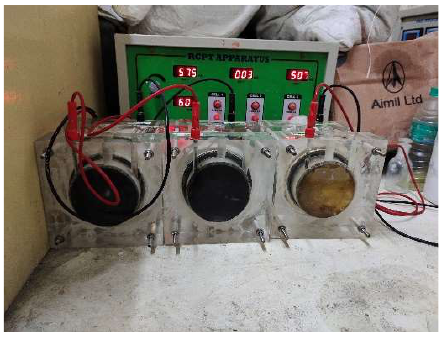
Figure 5. Typical setup of RCPT.